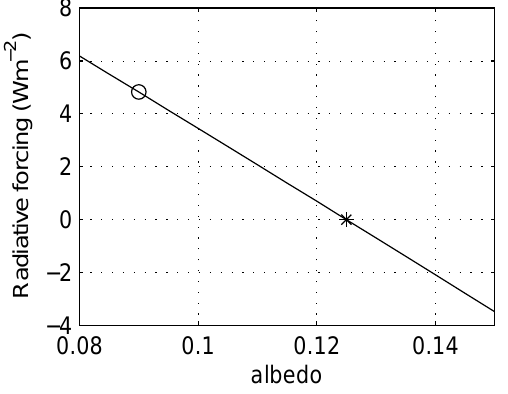
Fig. 10. Radiative forcing with changed surface albedo. ( S ) is the case study and ( ◦ ) is the end-member case of an ocean covered